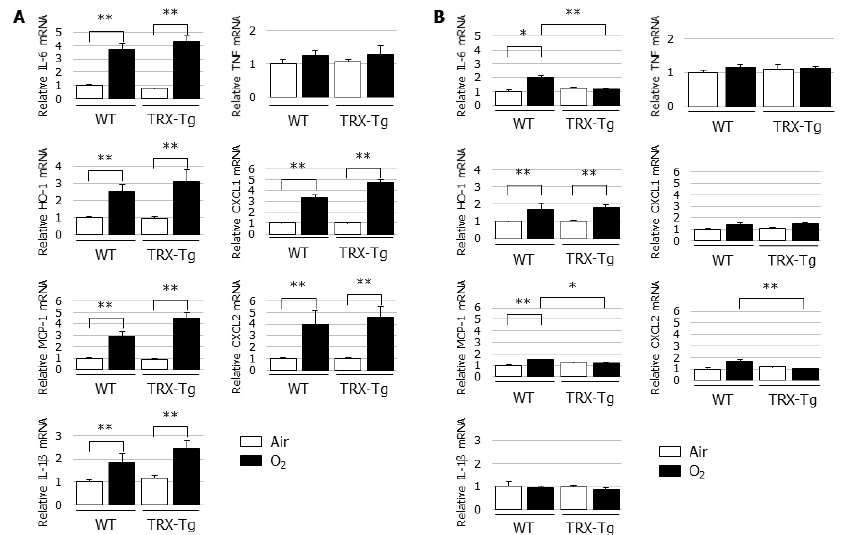
Figure 4. Changes in mRNA expression levels of Il-6 , Ho-1 , Mcp-1 , Il-1 β , Tnf , Cxcl1 , and Cxcl2 in lungs. Quantitative RT-PCR was performed on ( A ) day 4 and ( B ) day 14 ( n = 6 per group). Animals were exposed to air (open bars) or O 2 (filled bars). Data are shown as means ± SEM. Comparison between groups were performed using one-way ANOVA followed by Tukey’s test. * p < 0.05; ** p < 0.01. IL: Interleukin; HO: Heme oxygenase; MCP-1: Monocyte chemotactic protein-1; TNF: Tumor necrosis